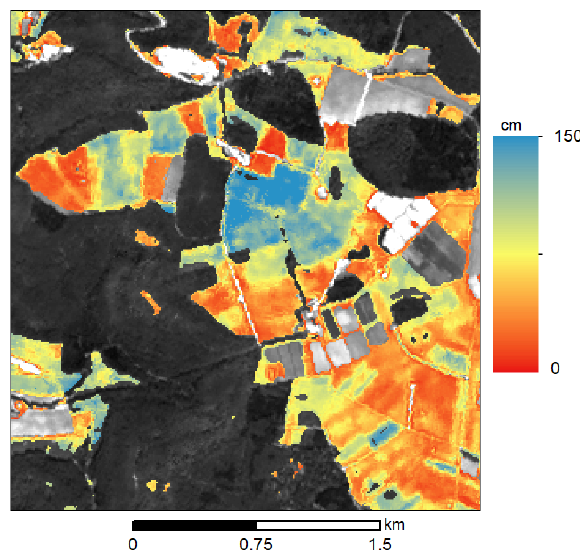
Figure 10: Plant height in grasslands during mid May 2020, modelled with Sentinel-2.